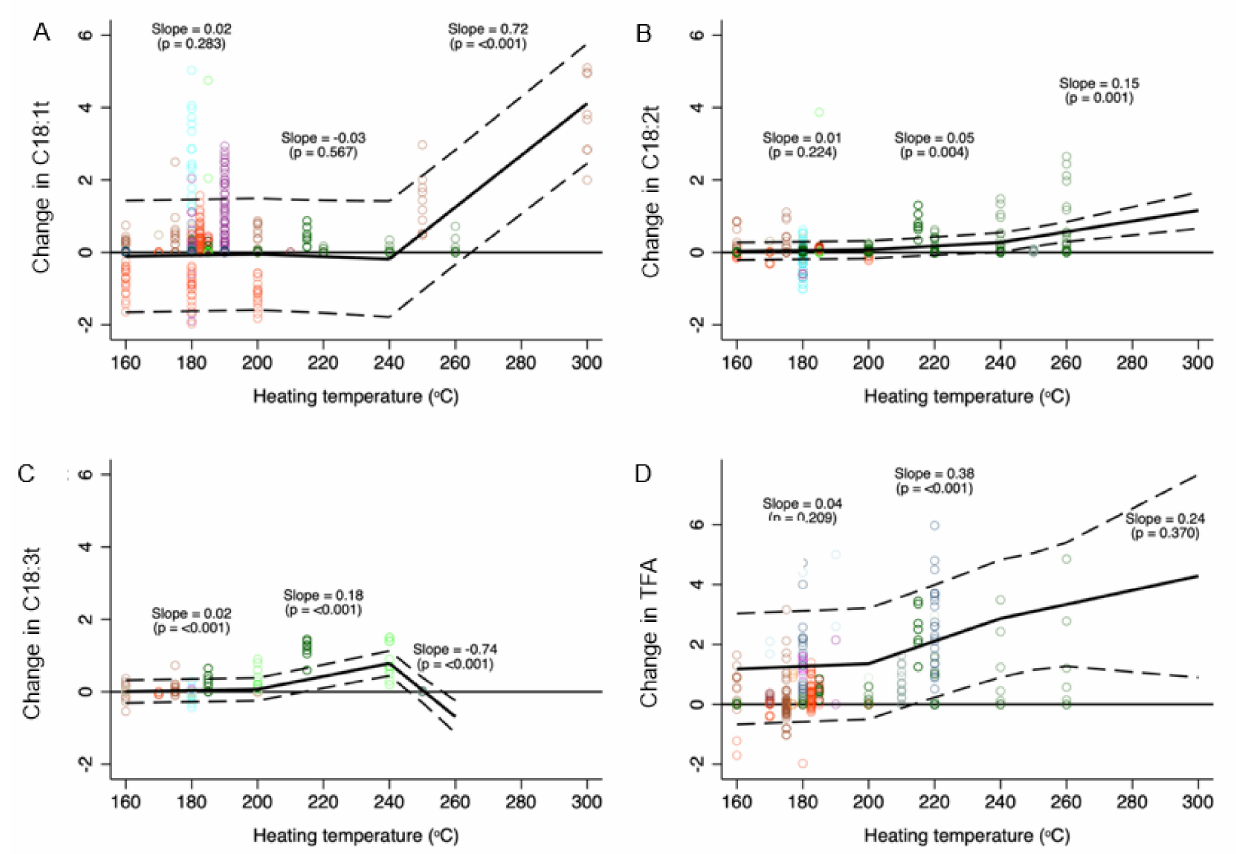
Figure 2. Change in C18:1t ( A ), C18:2t ( B ), C18:3t ( C ), and total TFA ( D ) (% of total fatty acids) content of cooking oil as a function of heating temperature. Data were fitted using a mixed multilevel linear regression model adjusted for heating time and oil type with random intercepts for studies and spline knots at 200 and 240 ◦ C. Slopes represent change in TFA per 10 ◦ C change in heating temperature within a particular spline range (<200 ◦ C, 200–240 ◦ C, >240 ◦ C). Data point colours represent different